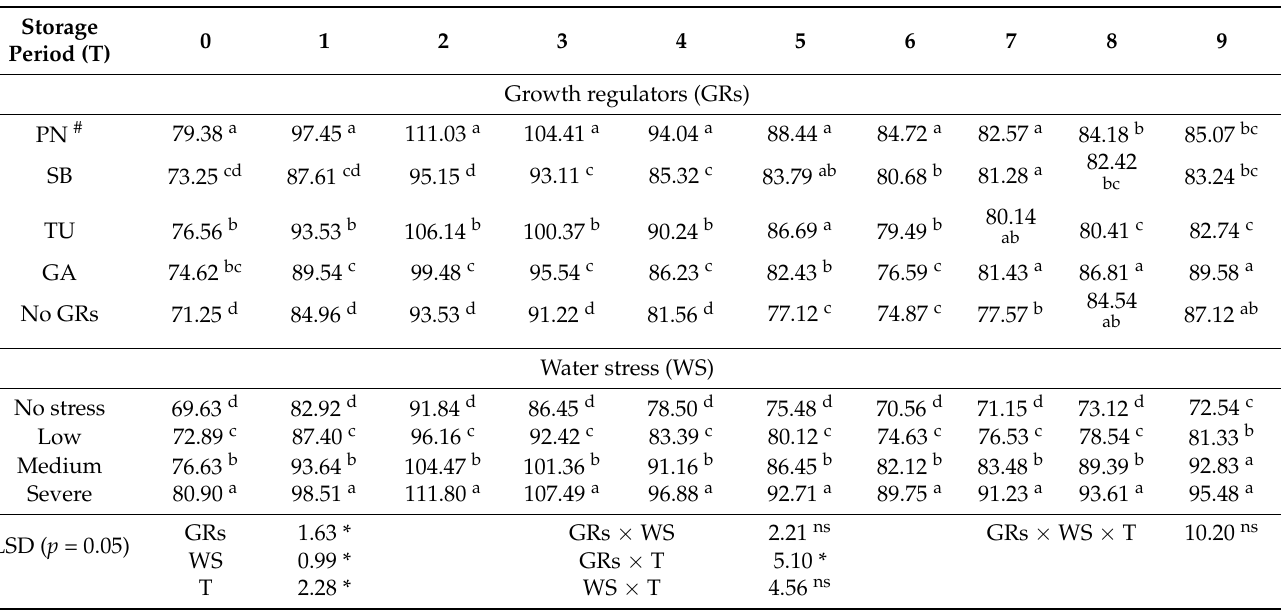
Table 6. Changes in POD (unit/100 g FW) of onions under different GRs and water stress levels during 9 months of